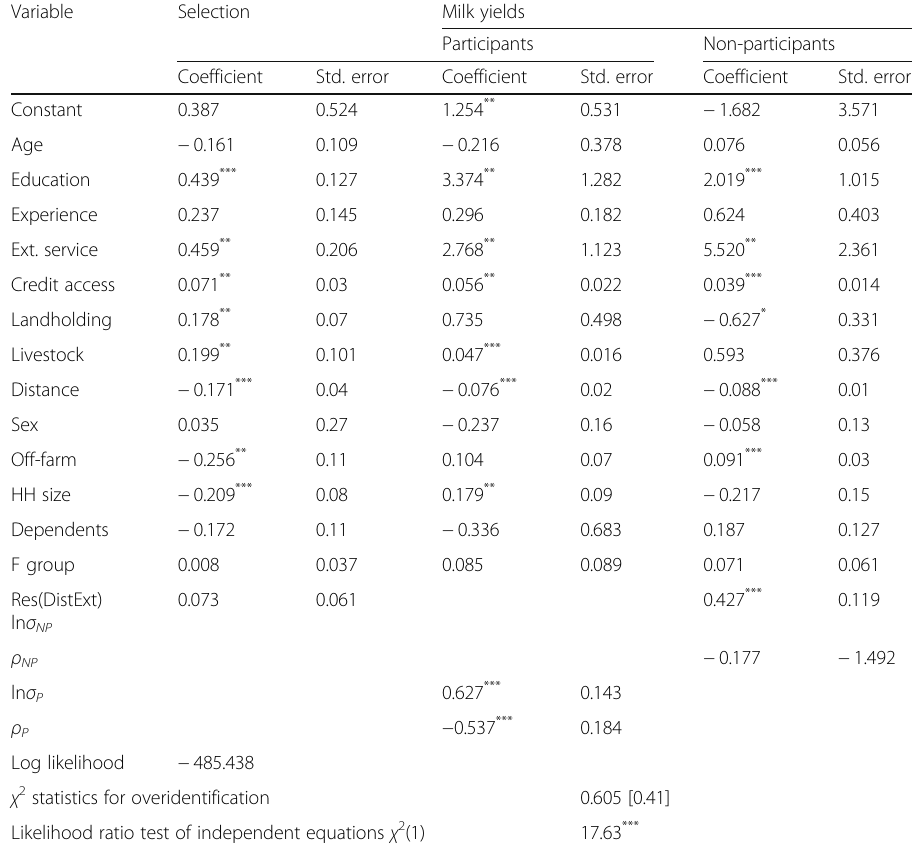
Table 2 Determinants of dairy hub participation and the impact of participation on milk yields Variable Selection Milk yields Participants Non-participants Coefficient Std. error Coefficient Std. error